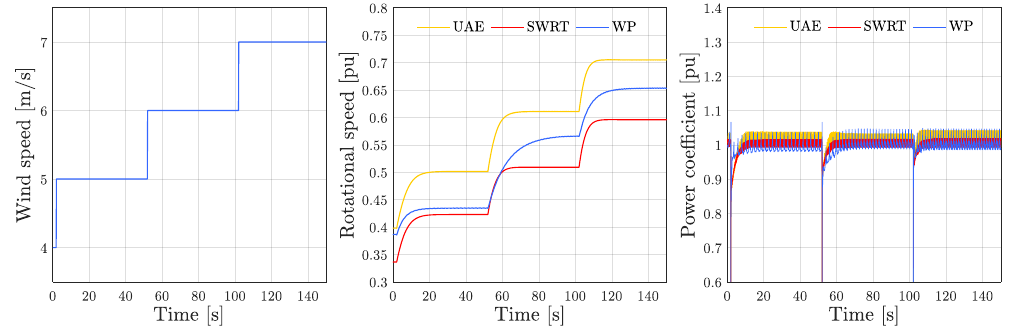
Figure 7. Dynamic performance of the SWRT, UAE, and WP wind turbines in the low wind region.